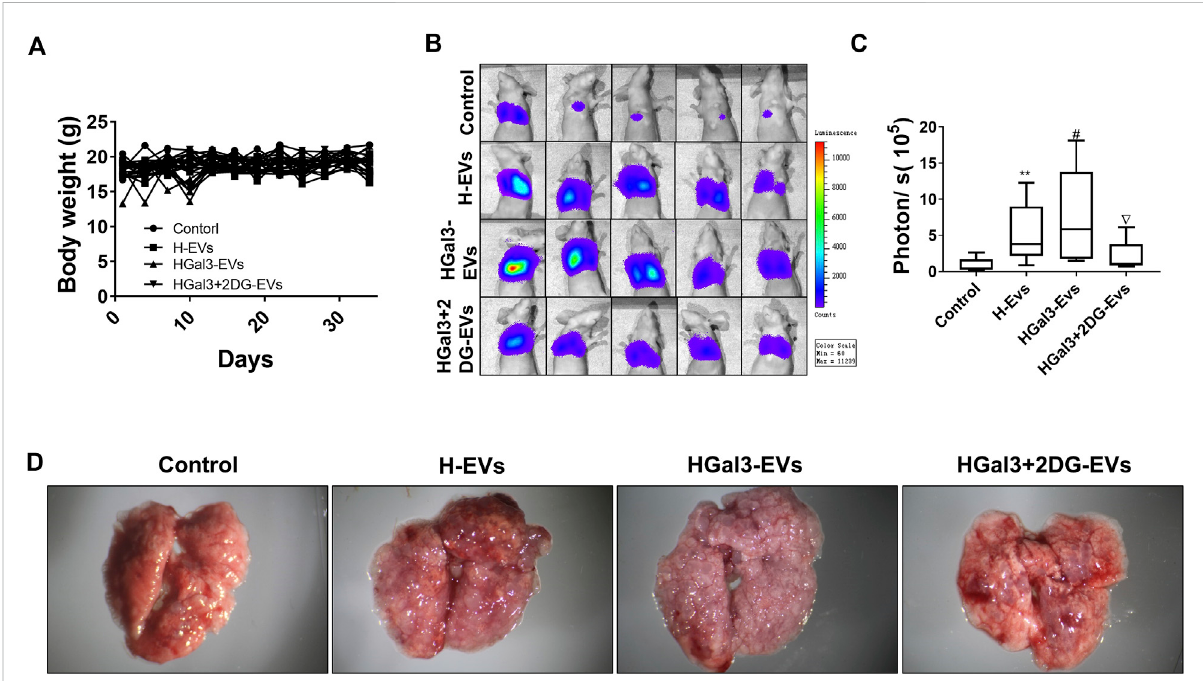
FIGURE 5 HGal3-EVs promoted lung metastasis of MDA-MB-231 cells by enhancing the glycolysis of HUVECs in nude mice. (A) The body weight of mice wasrecordedevery 3 days for 5 weeks. (B) The lungmetastasis ofMDA-MB-231 cellswasobservedusing an invivo imaging system. (C) Quantitative bioluminescence intensity of pulmonary metastatic cells. (D) Representative lung tissue in each group. All data are presented as means ± SD, n = 5, ** p < 0.01 v.s. control group; # p < 0.05, v.s. H-EVs group; ∇ p < 0.05, v.s .